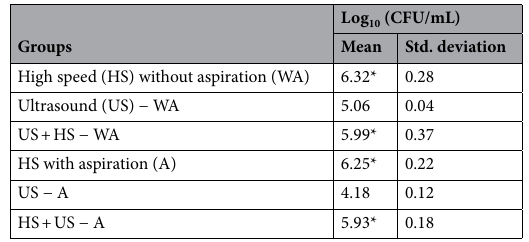
Table 2. Data of the environmental contamination produced by the systems. Comparison by ANOVA and Tukey’s post hoc tests. *No statistically significant differences.